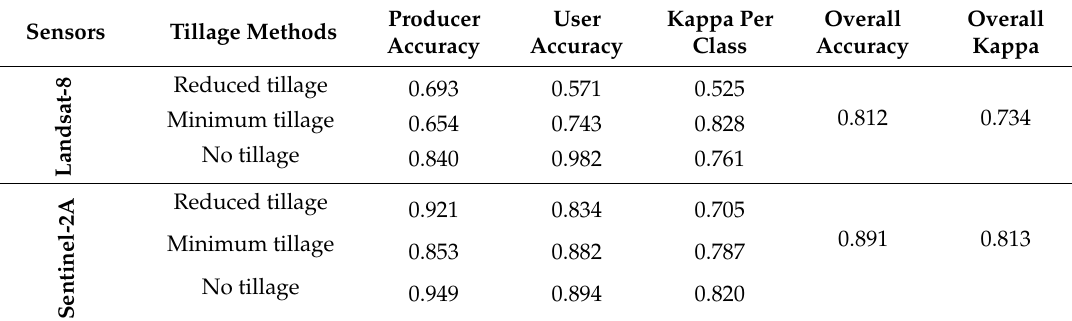
Table 7. Accuracy assessment of the NN classification method using OBIA for Landsat-8 and Sentinel-2A